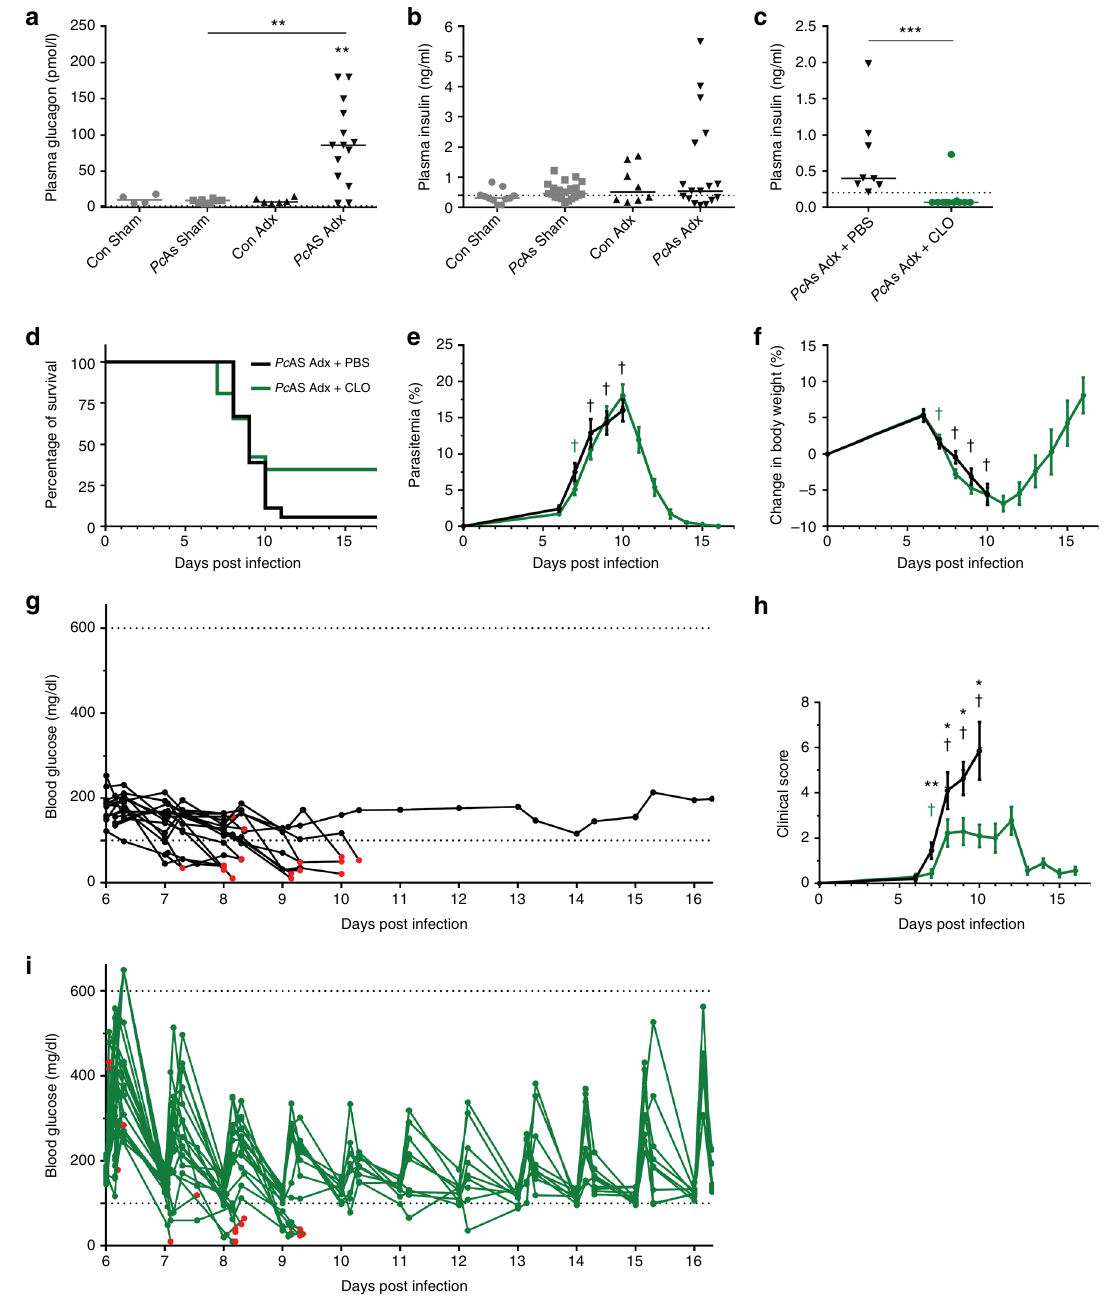
Fig. 7 Inhibition of insulin secretion by clonidine cannot revert lethal hypoglycemia in PcAS-infected Adx mice. a , b Sham and Adx C57BL/6 mice were infected with Pc AS. Mice were euthanized and dissected at 8 to 10 days p.i. and plasma glucagon and insulin levels were measured. c – i Adx C57BL/6 mice were infected with Pc AS. Daily clonidine (CLO) treatment was started at 6 days p.i. by IP injection of a dose of 0.5 mg/kg or 1 mg/kg clonidine hydrochloride dissolved in PBS if glycemia was, respectively, above or below 100 mg/dL. Control mice were treated with the corresponding volume of PBS. c Plasma insulin levels at 8 to 10 days after infection. The dotted lines represent the limits of detection. Each symbol represents data from an individual mouse, with n = 11 for Pc AS Adx + CLO. Horizontal lines in between data points represent group medians and analysis was by Mann-Whitney U -test. Horizontal lines with asterisks on top indicate the levels of statistical signi fi cance between the indicated groups. Asterisks above individual data sets indicate the levels of statistical signi fi cance compared to the uninfected control group. d Survival of mice was monitored daily. e , f , h The peripheral parasitemia, relative changes in body weight compared to day 0 and clinical scores were determined at the indicated time points. Data are means ± SEM and analysis was by Mann-Whitney U -test. Asterisks on top indicate a statistically signi fi cant difference between treated and untreated mice. Daggers ( † ) indicate when at least one mouse died or was euthanized when it reached humane endpoints. No data are shown for Adx + PBS after 10 days p.i. because two or fewer mice remained alive. g , i Blood glucose levels were measured in the morning, 1 h after clonidine injection and in the afternoon. Each curve represents the glycemia course of an individual mouse, black curves ( g ) for untreated mice and green curves ( i ) for treated mice. Red dots indicate the last glucose measurement before death. Graphs represent at least 4 separate experiments and the numbers of mice are as follows: n > 17 for Adx + PBS, n > 25 for Adx + CLO. * p < 0.05, ** p < 0.01, *** p <